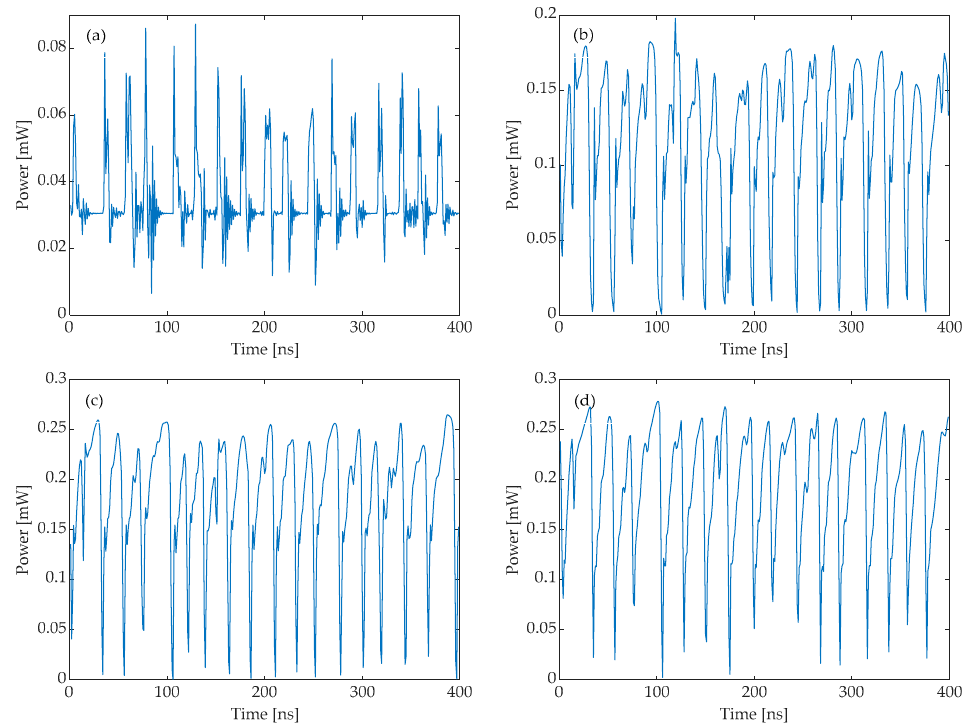
Figure 5. Output of response laser under different injection strengths. I D = I R = 15 mA, κ D = 50 ns − 1 .